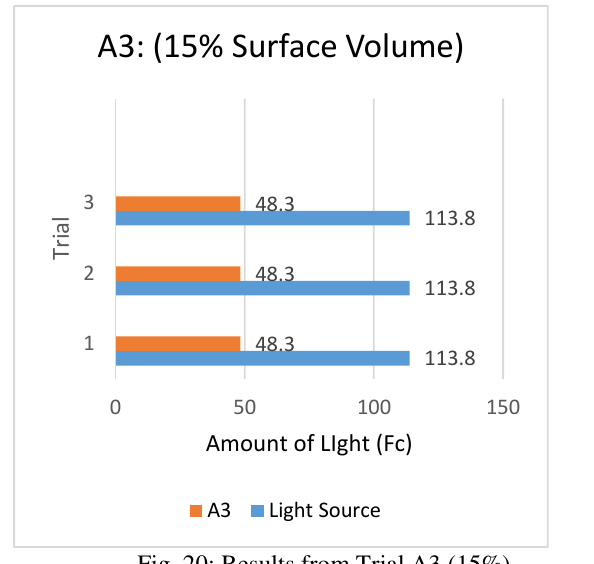
Fig. 20: Results from Trial A3 (15%) Average amount of Light Transmitted through each block is shown in Fig. 21.